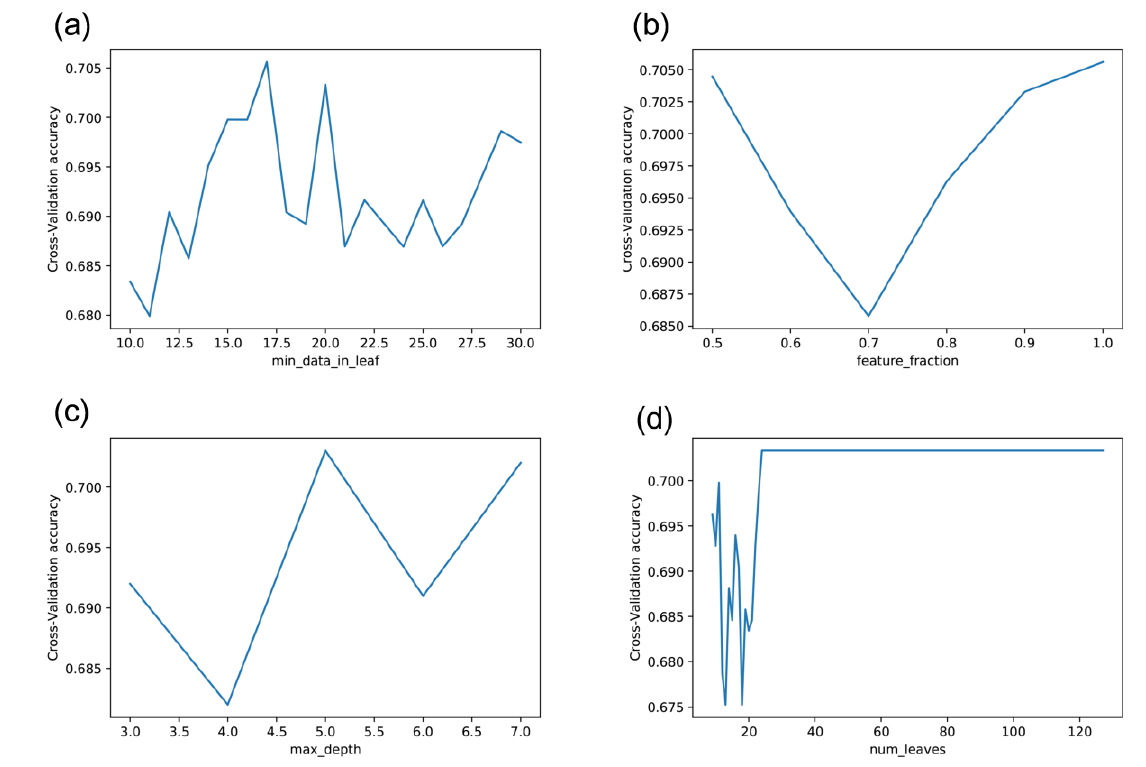
Figure 2. Effect of adjusting different parameters of LightGBM on accuracy: ( a ) min_data_in_leaf, ( b ) feature_fraction, ( c ) max_depth, ( d ) num_leaves.